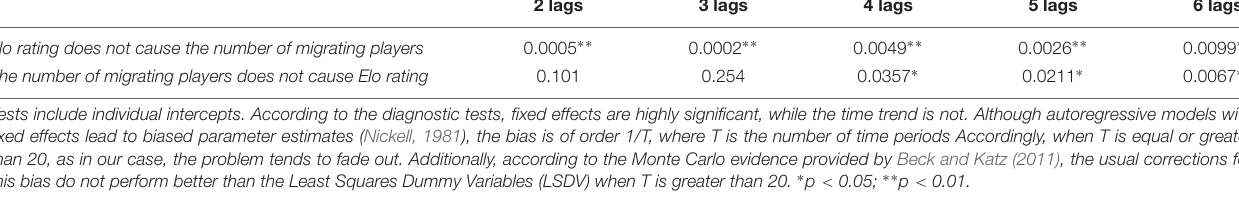
TABLE 3 | Causality tests for different lags structures ( p -values are shown). 2 lags 3 lags 4 lags 5 lags